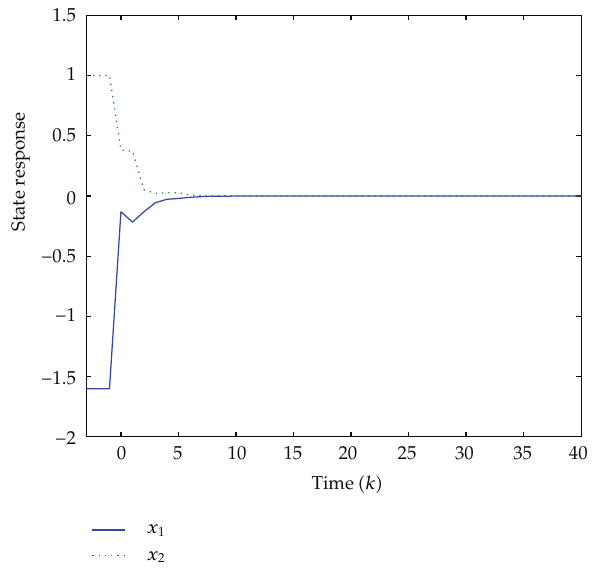
Figure 2: State response of the closed-loop system under saturated